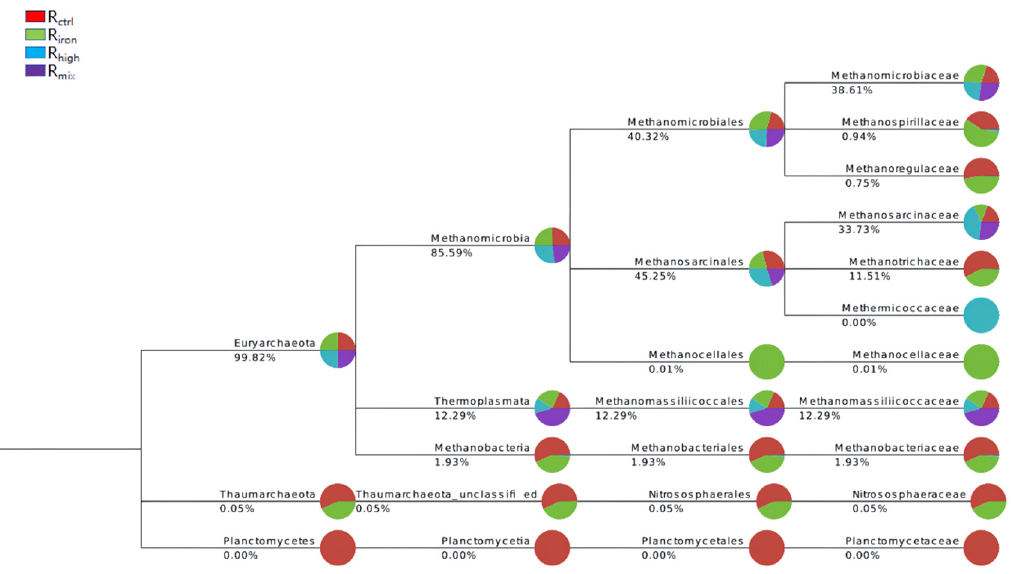
Figure 7. Changes in the composition of the archaeal community at different levels in the four reac- tors.